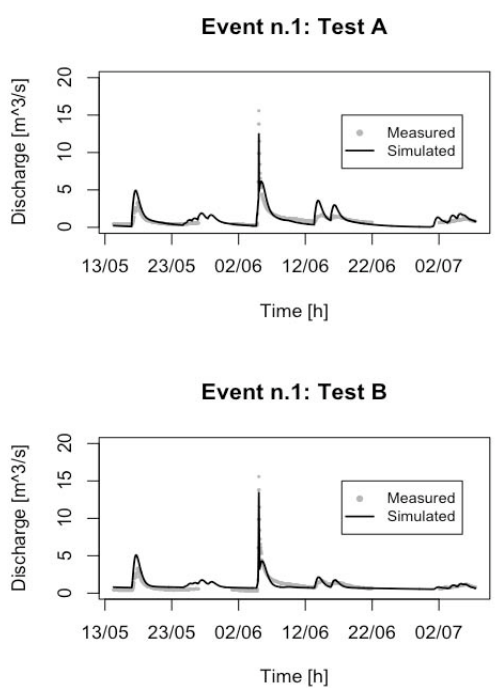
Fig. 3. Event No. 1: test case A at the top and test case B at the bottom. The year of the events registered is 2003.